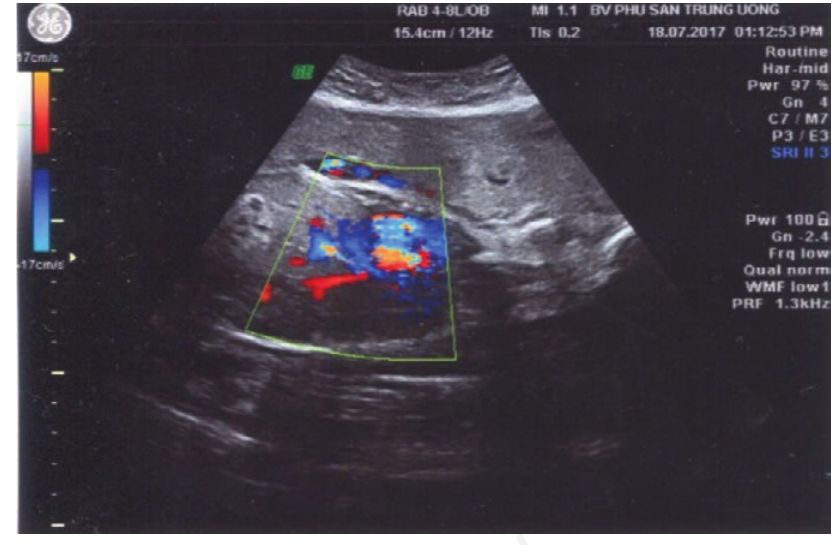
Figure 1. Imaging of DV located by color doppler.